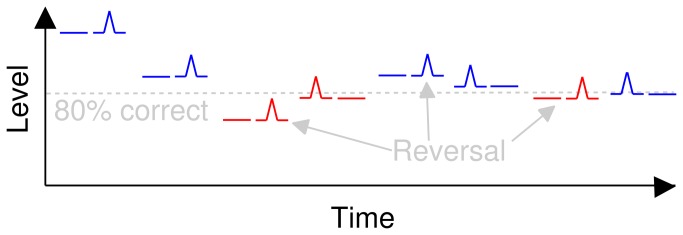
Illustration of the inverted method.Pairs of pure-tones are presented, one of which contains a ramped increment. The ramp size and duration is fixed throughout, whilst listening level is adaptively changed until the procedure converges on 80% correct performance. When the listener correctly identifies the location of the ramped intensity increment the listening level is reduced, otherwise the listening level is increased, depending on a rule (simplified here to a 1-up, 1-down rule). Correct responses (blue) result in decreased listening level and incorrect responses (red) result in increased listening level. The 80% correct threshold level is estimated by averaging the listening level measured at several points where the adaptive procedure changes direction (‘reversals’). The step size of the level change reduced after a reversal and the procedure eventually converges on the 80% correct point.